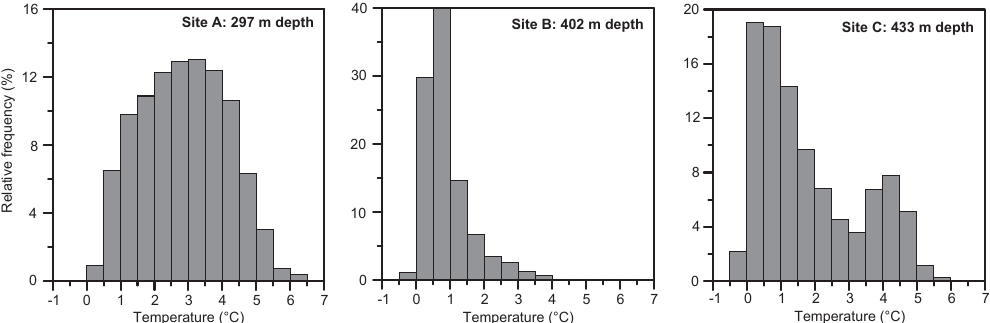
Figure 7. Histograms of bottom temperature at the three deployment sites based on hourly values. Note that the y axes on the three panels have different scales.